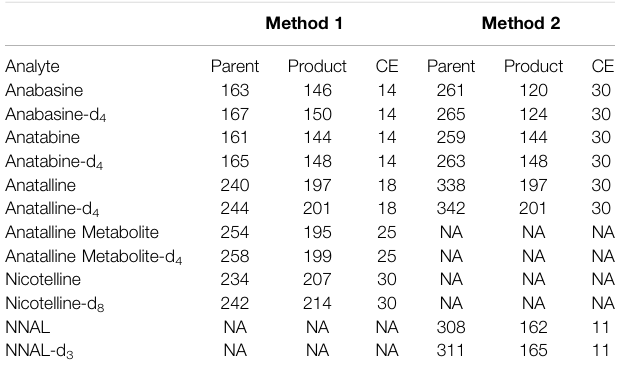
TABLE 1 | SRM transitions and collision energies (CE) for analytes and internal